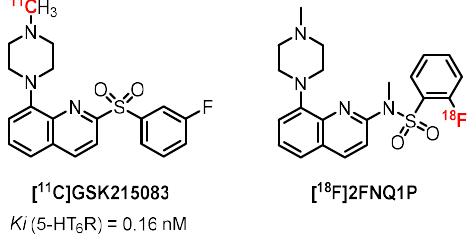
Figure 16. [ 11 C]GSK215083 and [ 18 F]2FNQ1P